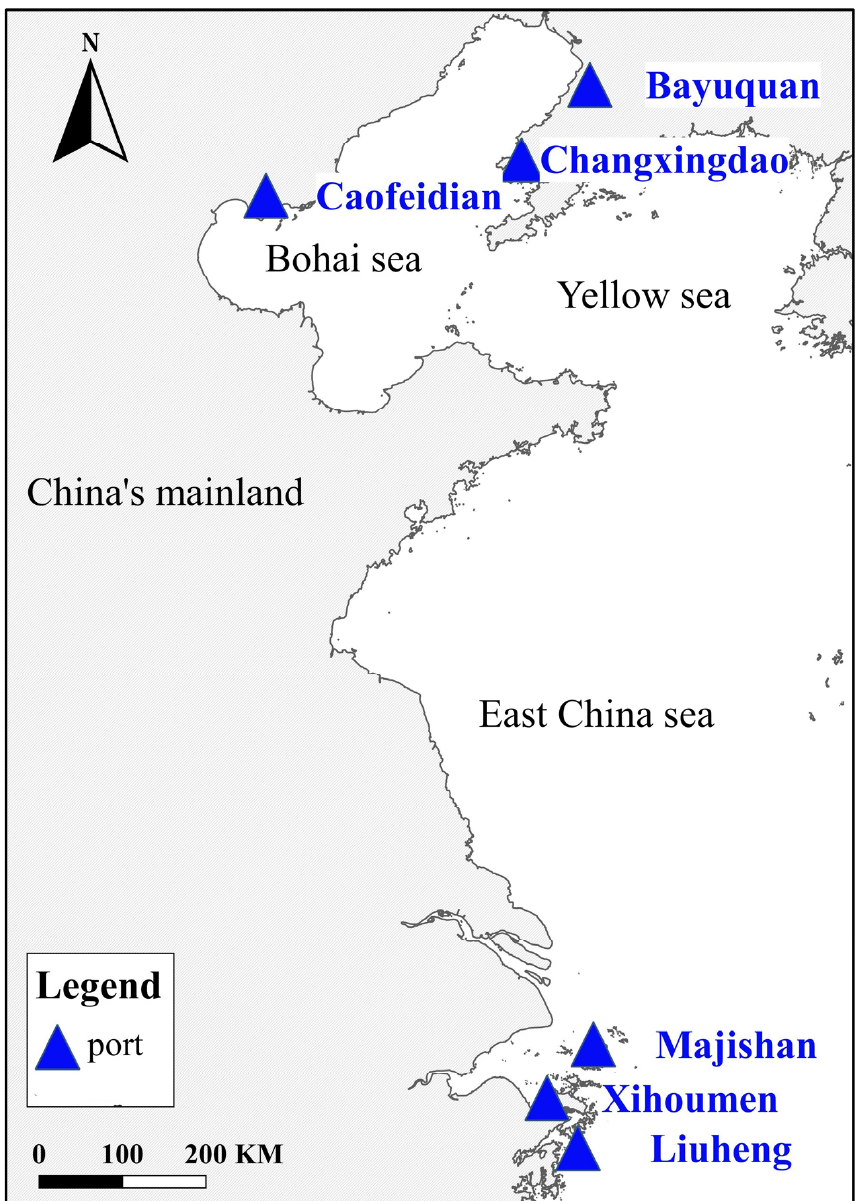
Figure 3. Schematic diagram of the study area.